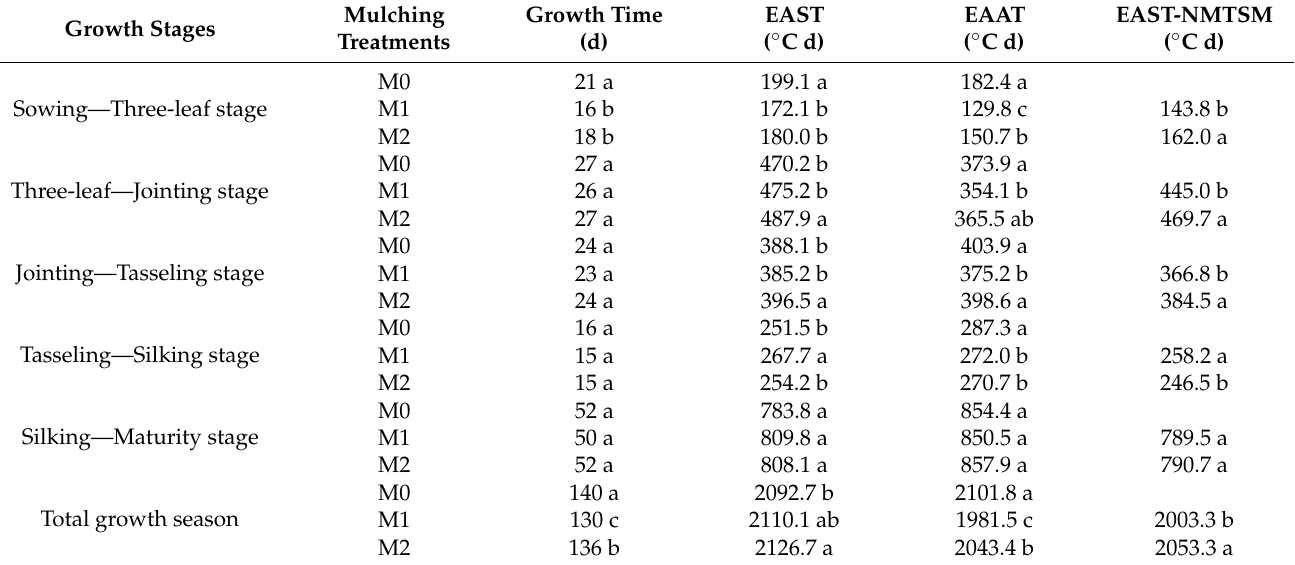
Table 1. Influence of different film mulching treatments on maize developmental progress, the effective accumulated soil temperature (EAST), the effective accumulated air temperature (EAAT) and the effective accumulated soil temperature under no mulching when the time is the same as plastic film mulching (EAST-NMTSM) in 2016. Different letters are significantly different at the p < 0.05 probability level.